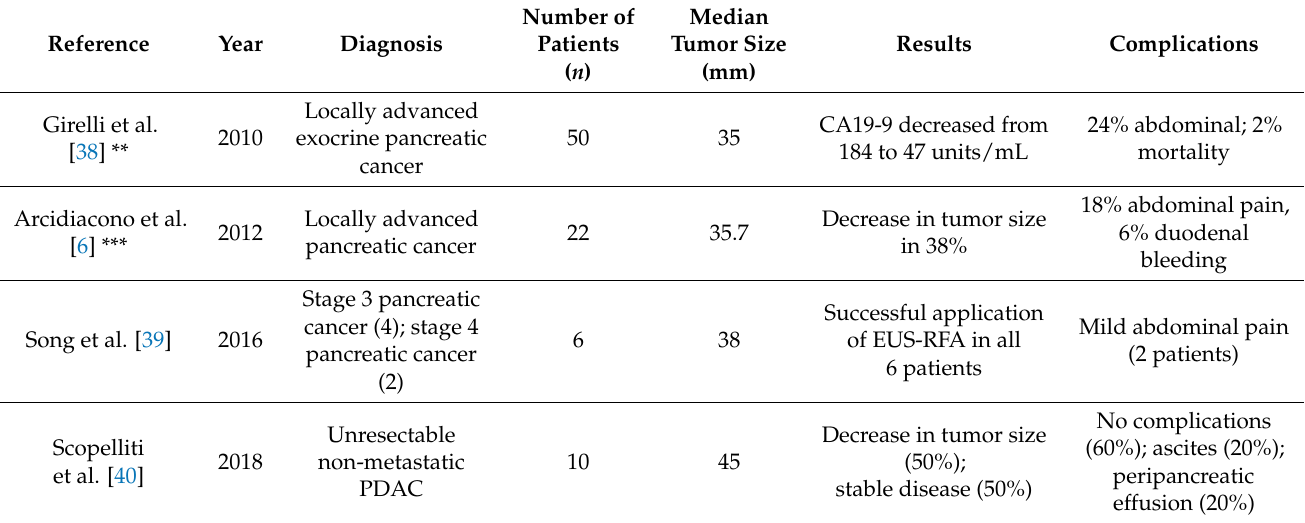
Table 1. Selected publications: EUS-RFA for the treatment of pancreatic